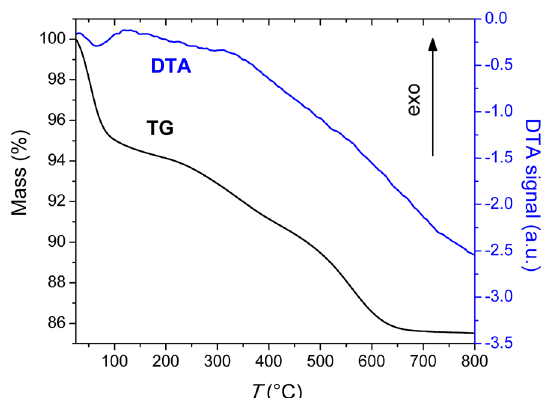
Figure 2. TG-DTA analysis of AzoMCM.